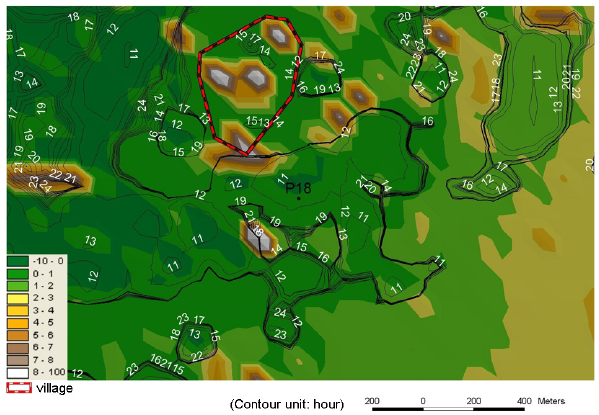
Fig. 13. Topography around P18 with the inundation contours of 20-cm depth advancing with elapsed time (by hour) in Typhoon Sepat.